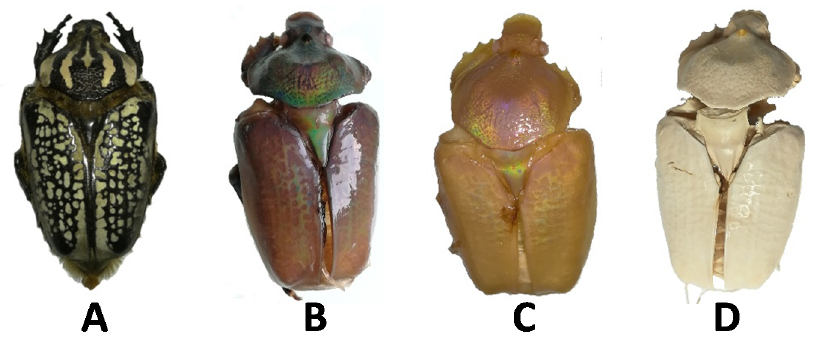
Figure 3. Example of G. orientalis morphological evolutions. ( A ) Starting specimen; ( B ) Specimen after deproteination; ( C ) Specimen after bleaching; ( D ) Specimen after drying.